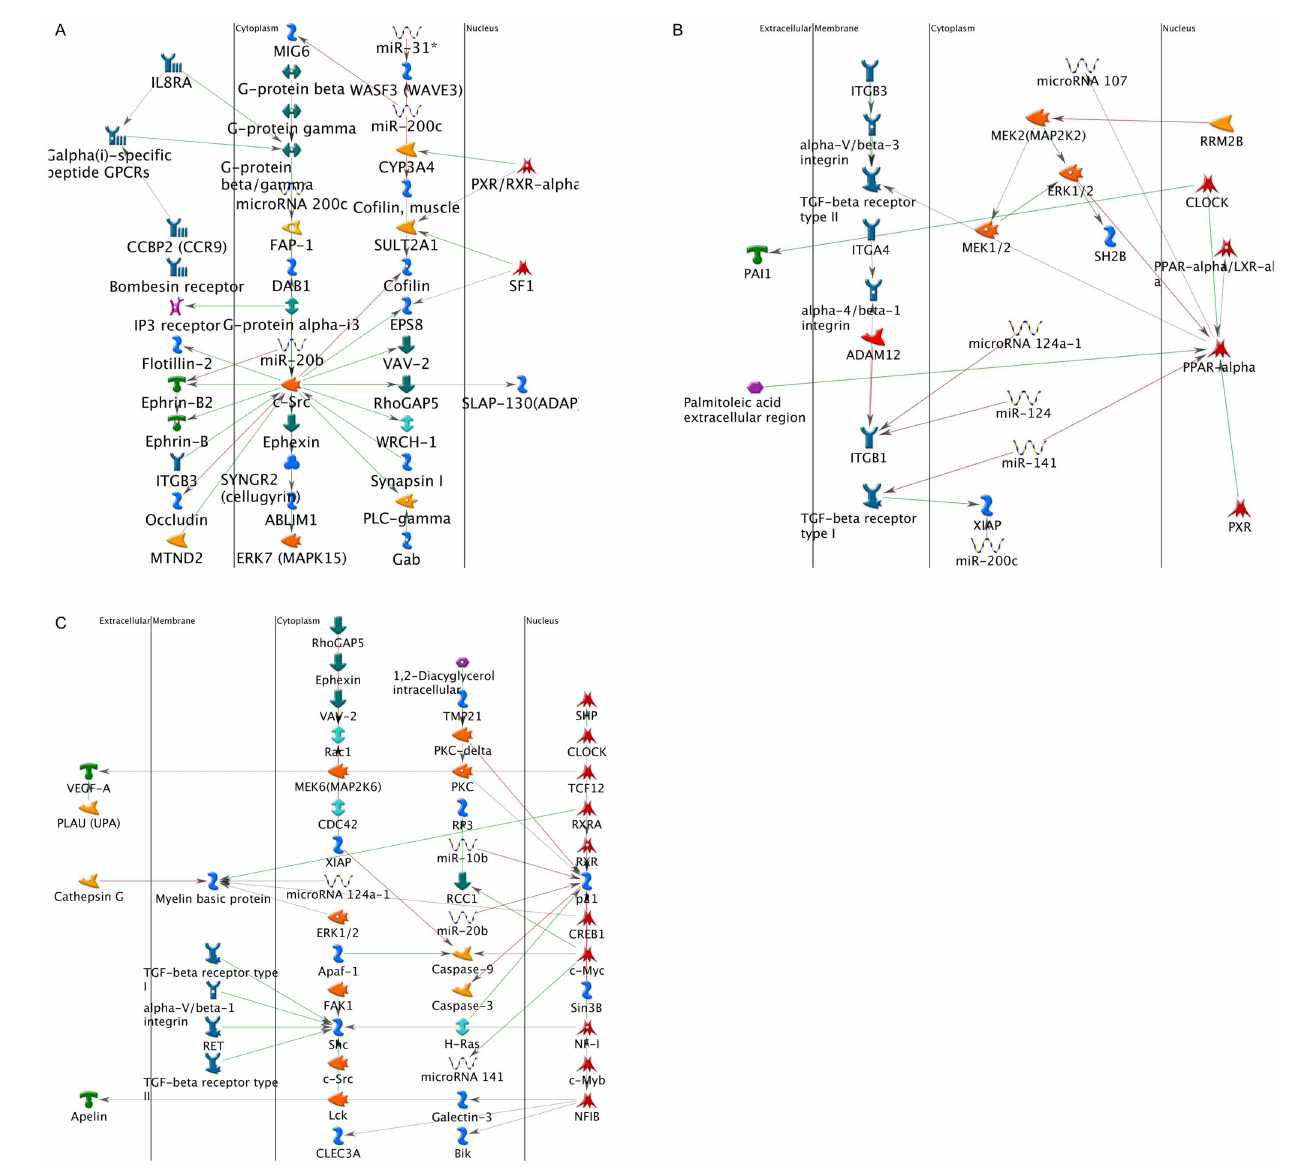
Figure 2. Biological networks modulated by the differentially expressed miRNA in chronic HCV. The biological networks modulated by differentially expressed miRNA following HCV infection was analyzed using the Genego software. Genego analysis of the networks identified: a) regulation of the phospholipase C pathway (miR200c, miR20b, and miR31 through cSrc); b) response to endogenous stimulus of growth factors and hormones (miR141, miR107 and miR200c through PPAR- a and ERK); and c) regulation of cellular proliferation (miR20b, miR10b, and miR141 through p21) as the major biological pathways that are impacted.